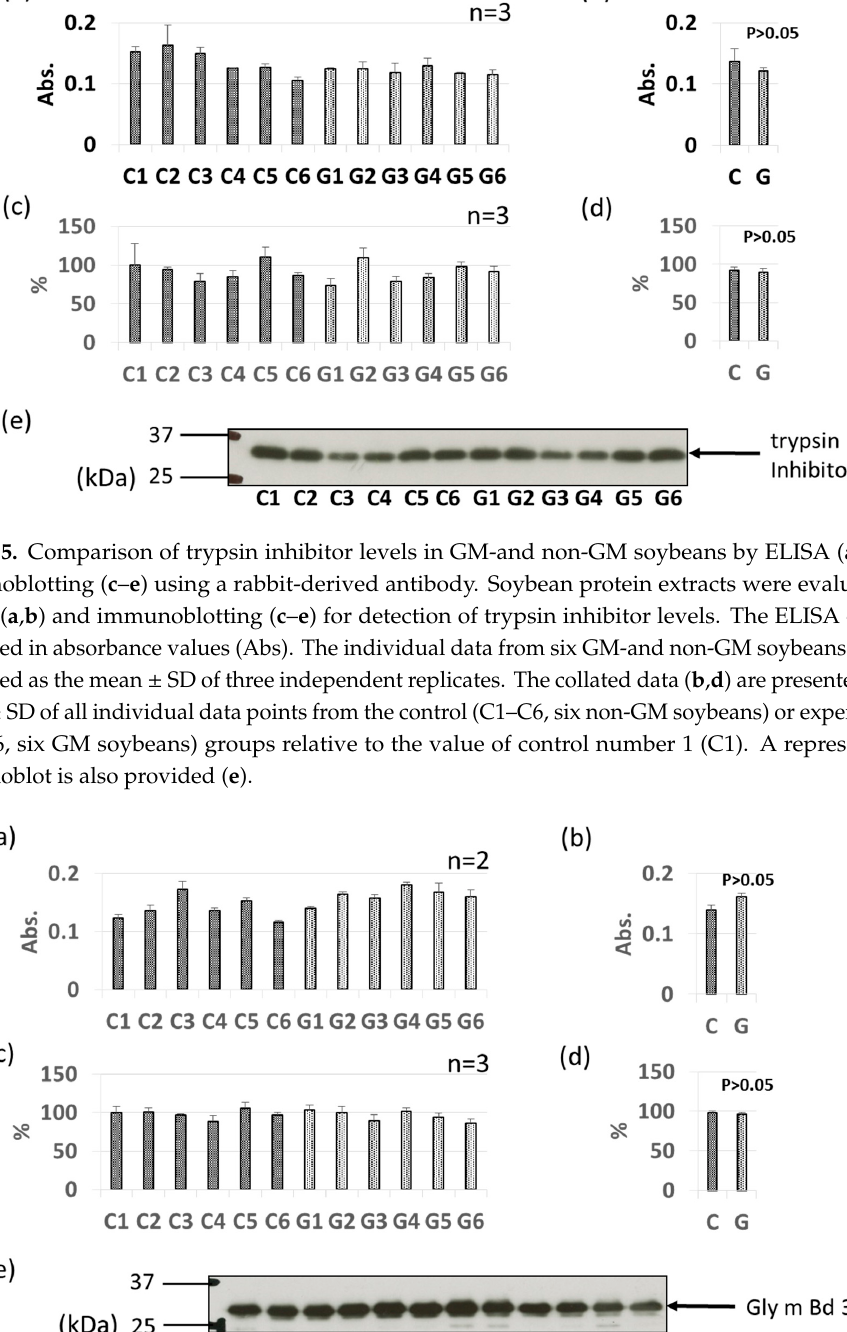
Figure 6. Comparison of Gly m Bd 30K levels in GM-and non-GM soybeans by ELISA ( a , b ) and immunoblotting ( c – e ) using a mouse-derived monoclonal antibody. Soybean protein extracts were evaluated by ELISA ( a , b ) and immunoblotting ( c – e ) for detection of Gly m Bd 30K levels. The ELISA data are presented in absorbance values (Abs). The individual data from six GM-and non-GM soybeans ( a , c ) are presented as the mean ± SD of three independent replicates. The collated data ( b , d ) are presented as the mean ± SD of all individual data points from the control (C1–C6, six non-GM soybeans) or experimental (G1–G6, six GM soybeans) groups relative to the value of control number 1 (C1). A representative immunoblot is also provided ( e